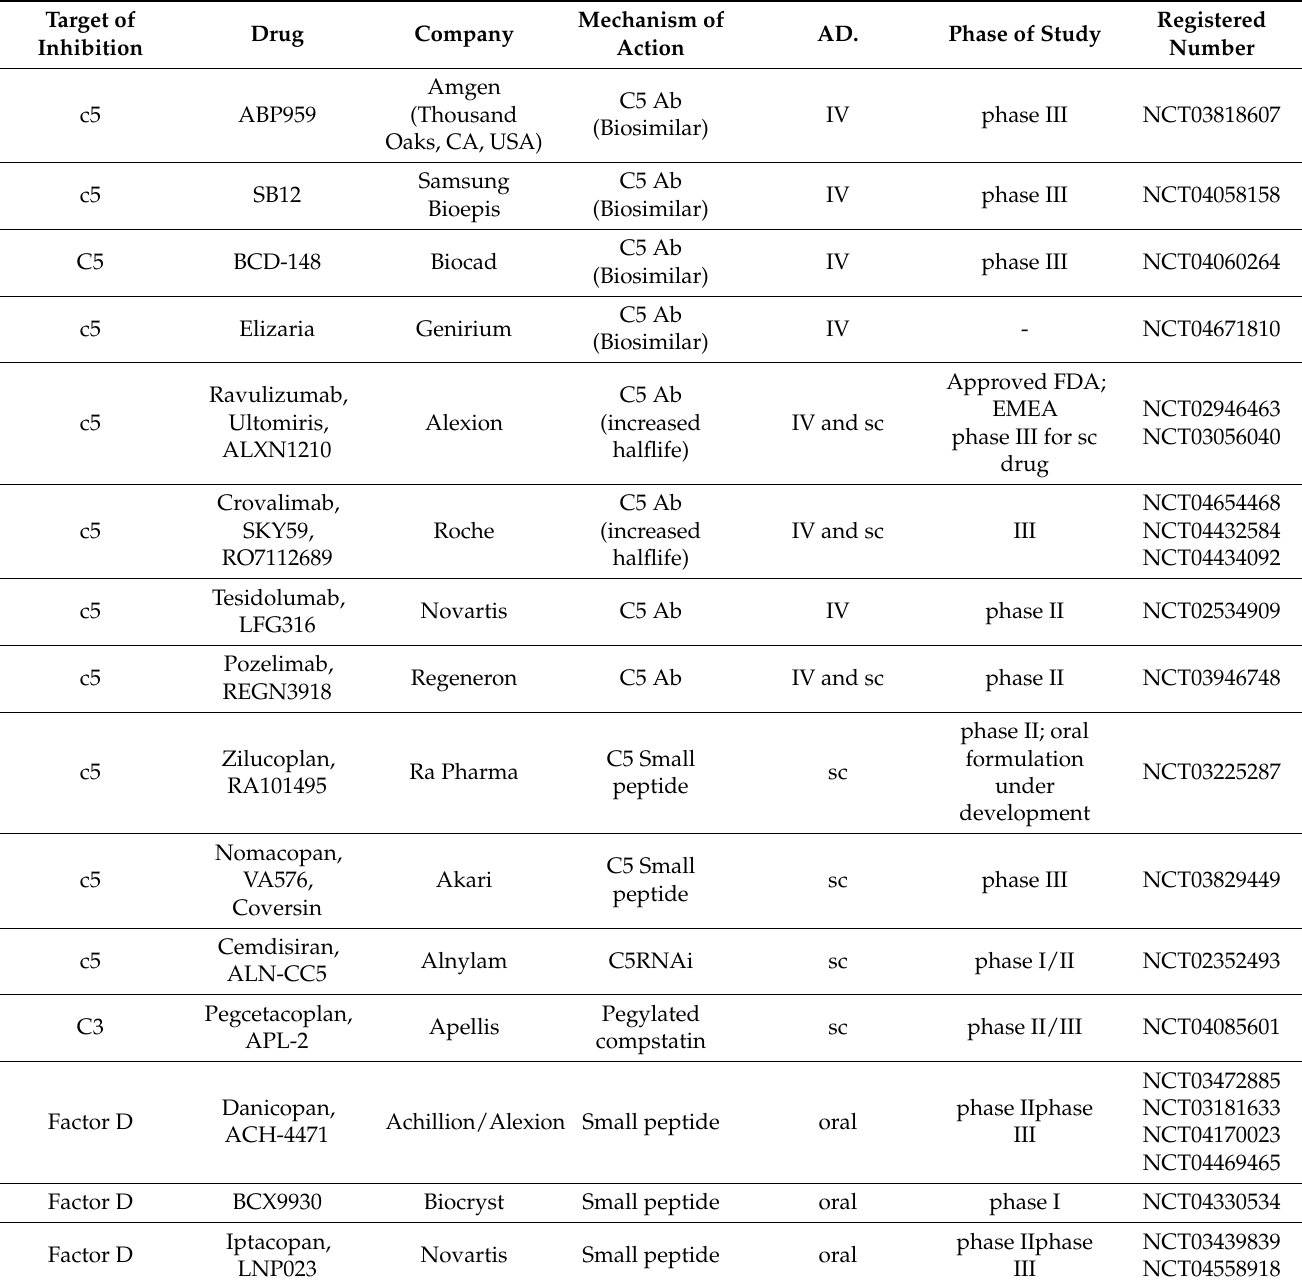
Table 2. Ongoing studies for new drugs for paroxysmal nocturnal hemoglobinuria. Target